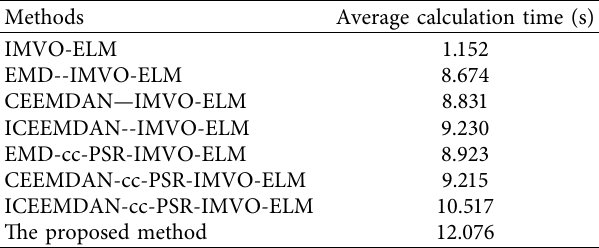
Table 4: The average calculation time of each